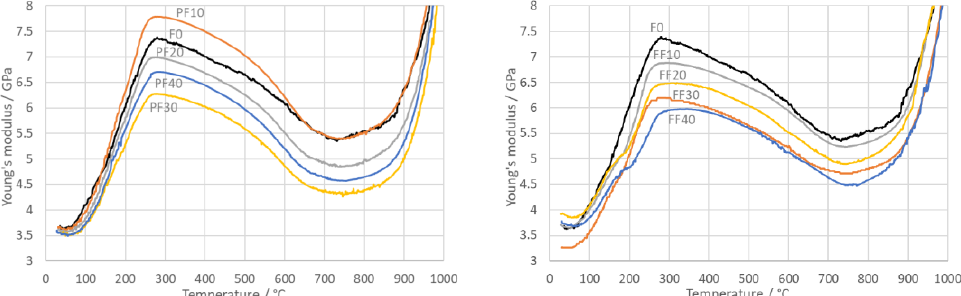
Figure 8. The Young’s modulus of PF ( left ) and FF ( right ) samples up to 1000 °C.